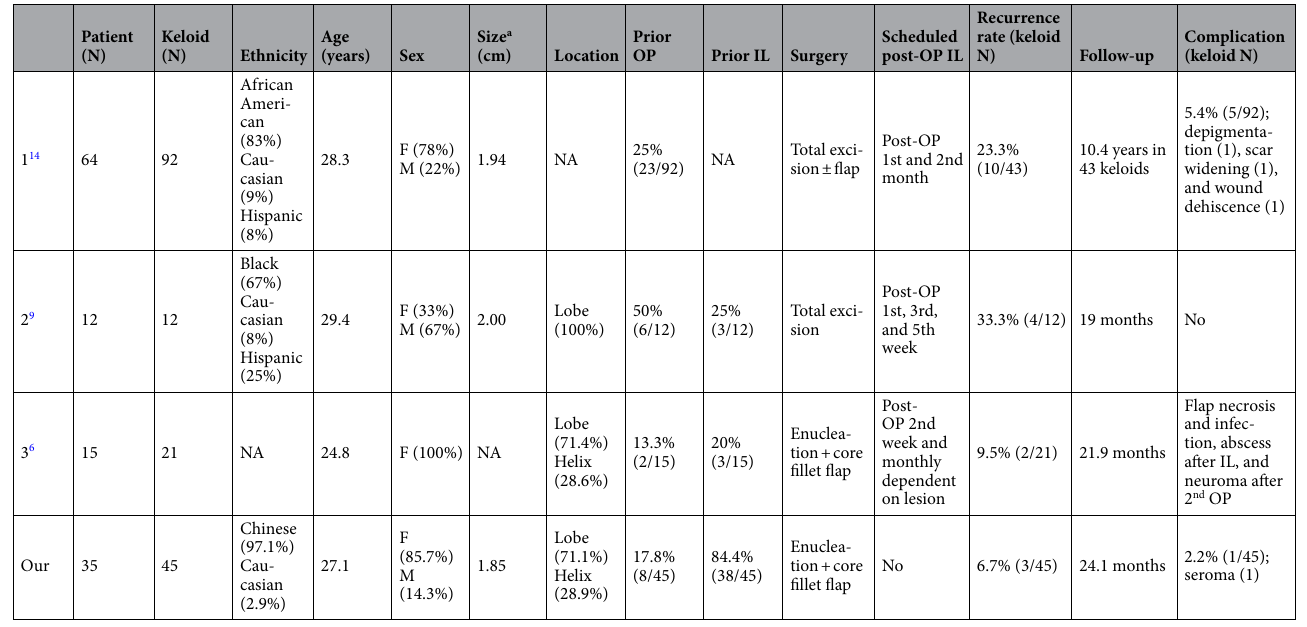
Table 4. Comparison with previous literatures adopting surgical excision with intraoperative [Triamcinolone acetonide (40 mg/cc)] and postoperative intralesional corticosteroid injection. a Size was shown with